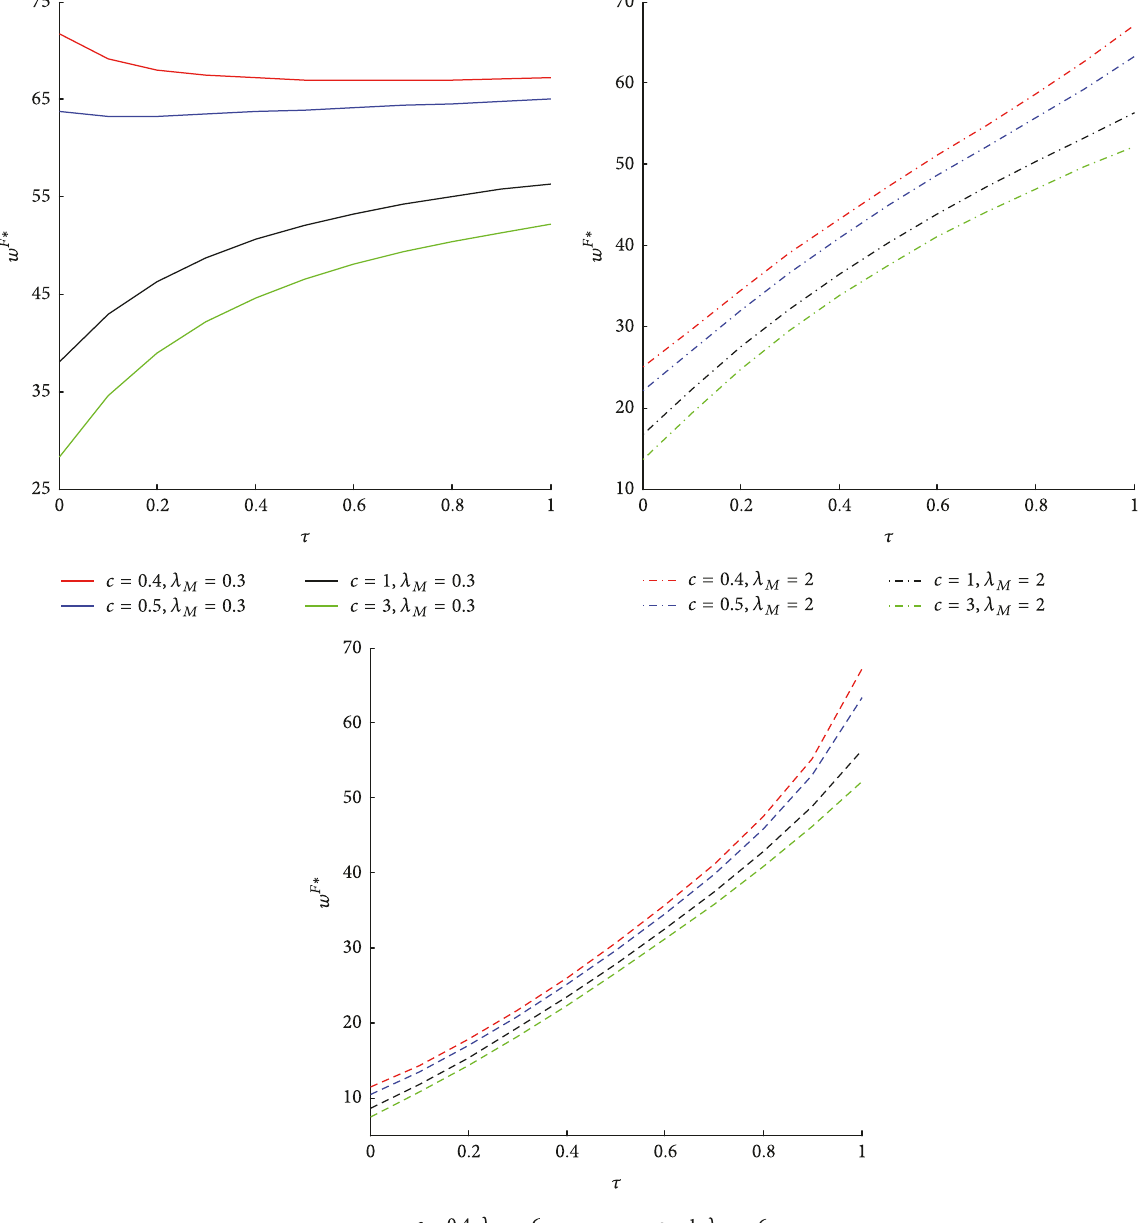
(b) 𝜕(𝑝 𝐹∗ )/𝜕𝜆 𝑀 < 0 ; (c) 𝜕(𝑝 𝐹∗ )/𝜕𝜆 𝑆 < 0 if 𝛼𝑇 > 2𝛽𝑐[1 + (1 − 𝜏)𝜆 𝑀 ] , and ⩾ 0 𝜕(𝑝 𝐹∗ )/𝜕𝜆 𝑆